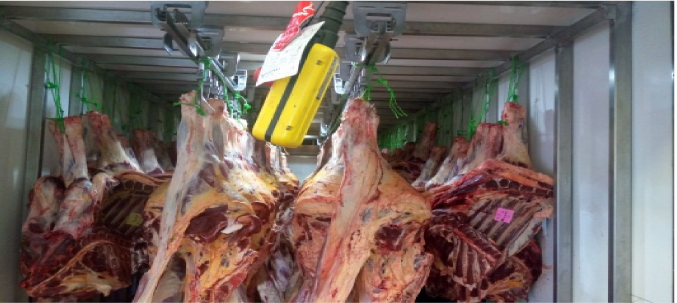
Figure 5. Modern transport of carcasses from the slaughterhouse to meat distribution